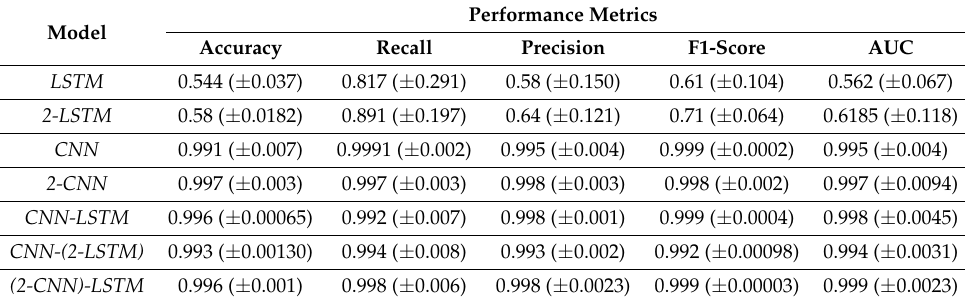
Table 3. Performance metrics of the tested models (using two sensors readings).